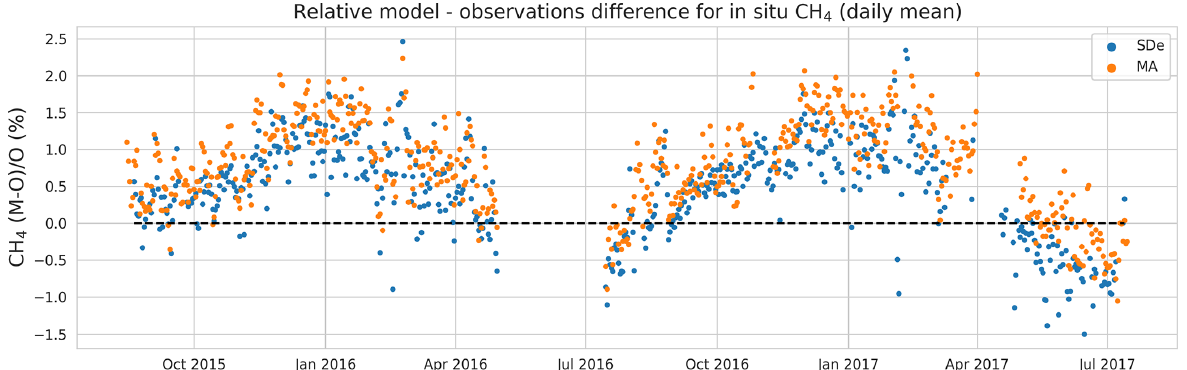
Figure 12. Time series of daily mean relative percentage differences between model and in situ observations of CH 4 at SDe (orange) and MA (blue). The black dashed line indicates zero